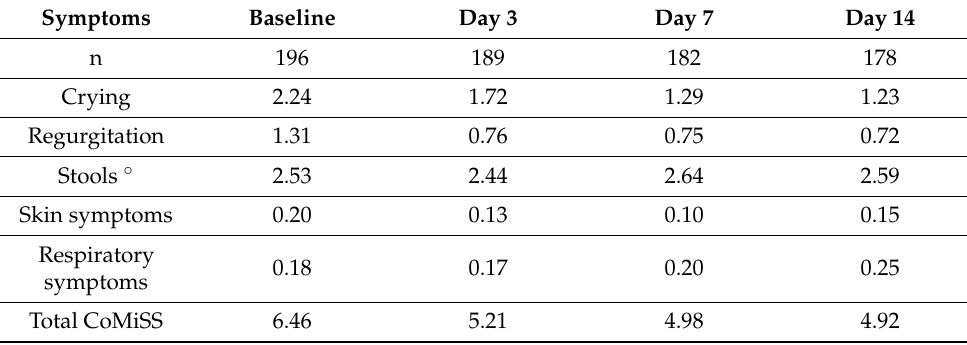
Table 5. Evolution of specific CoMiSS per time point.